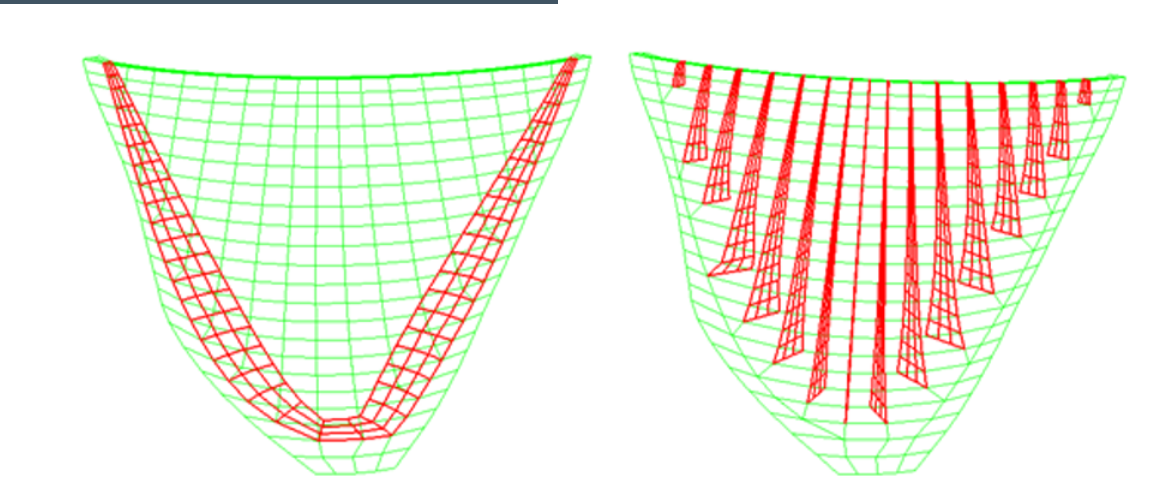
Figure 7. Dam body joints; peripheral joint (left); contraction joints (right)